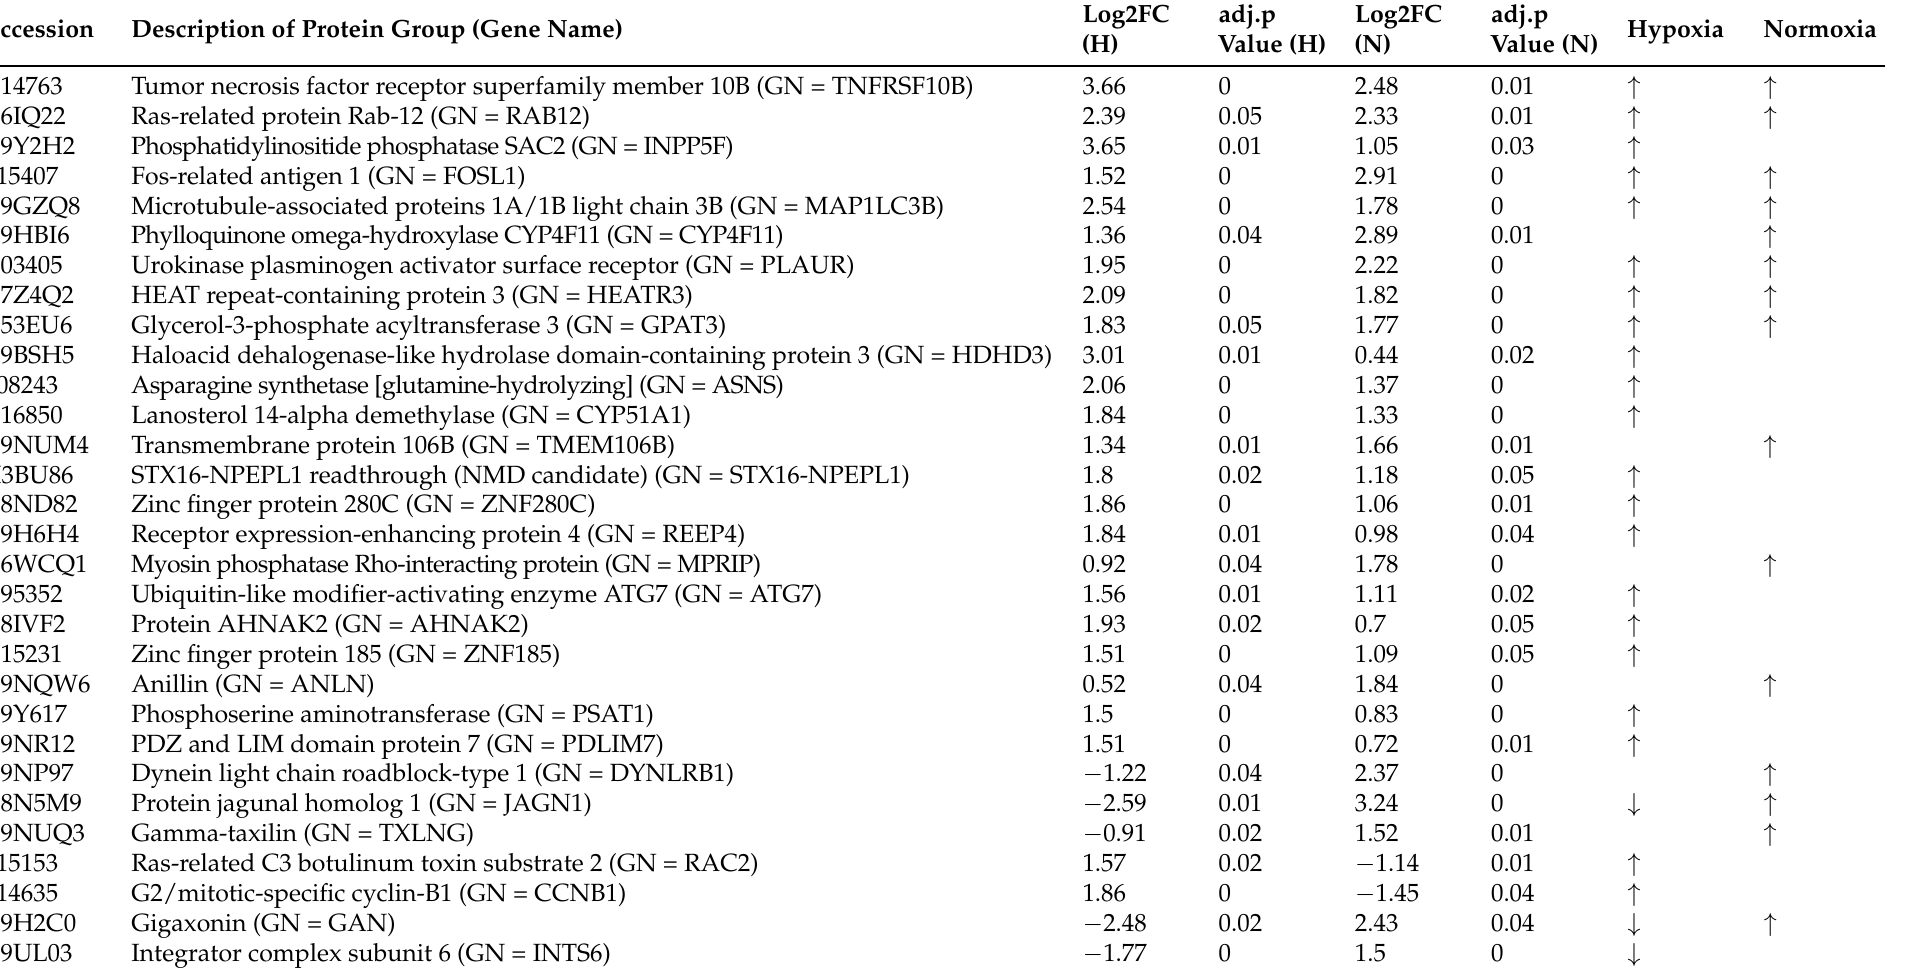
Table 2. List of significantly changed protein groups after SKR treatment in hypoxia (H) and normoxia (N). Log2FC is calculated between SKR-treated samples and control. Upregulation and downregulation labels: ↑ Log2FC ≥ +1.5 (upregulated); ↓ Log2FC ≤ − 1.5